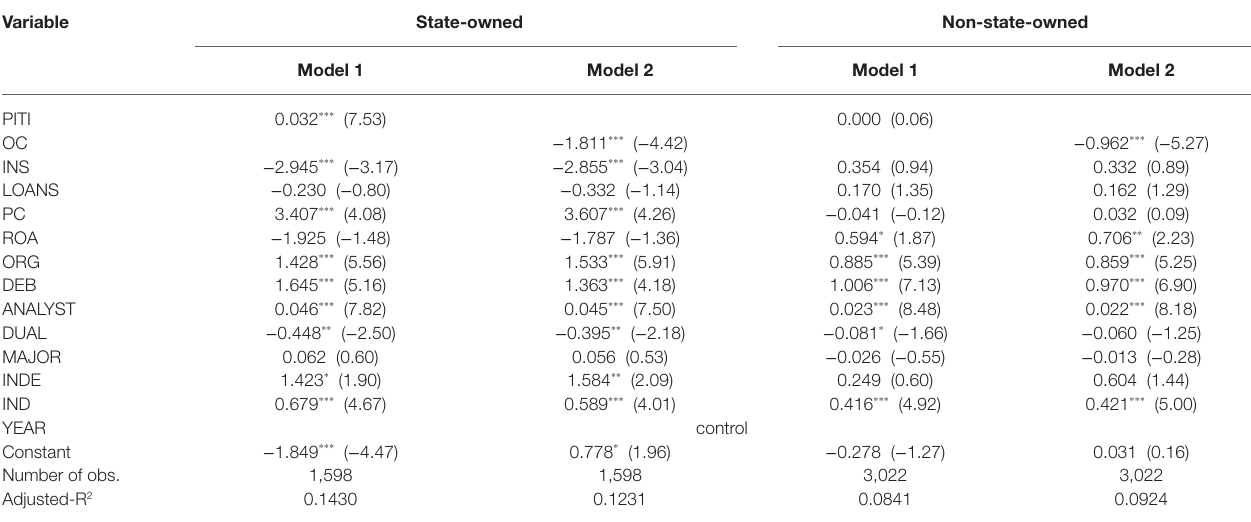
TABLE 9 | Regression results of further